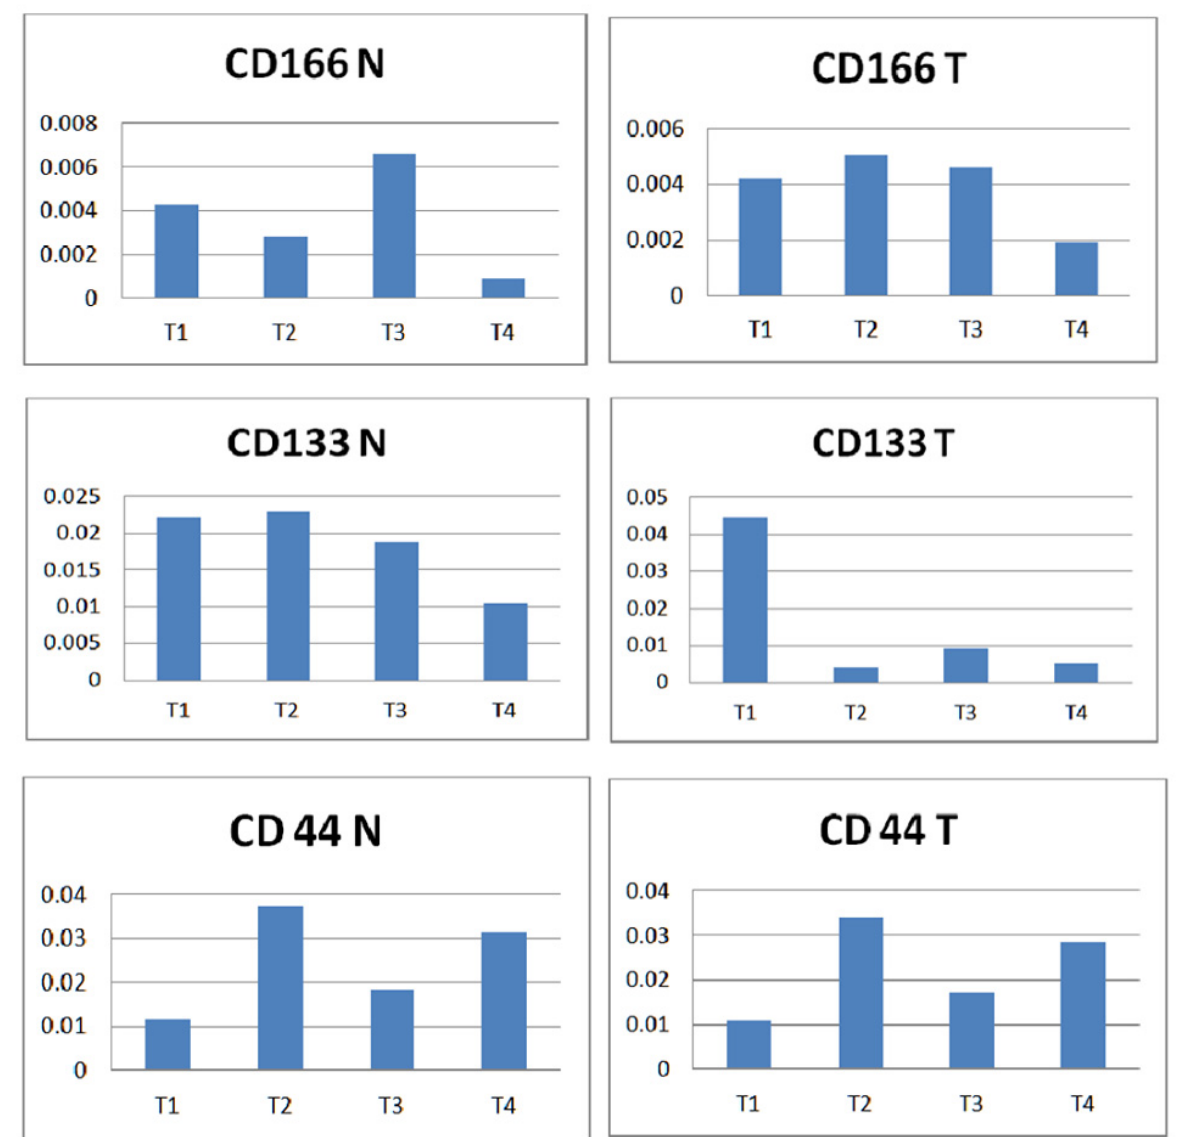
Figure 7. Normal versus tumor tissue expression of the three markers according to T staging. A non-parametric Kruskal–Wallis test was used to compare individual groups, and all values achieved statistical significance ( p < 0.05).